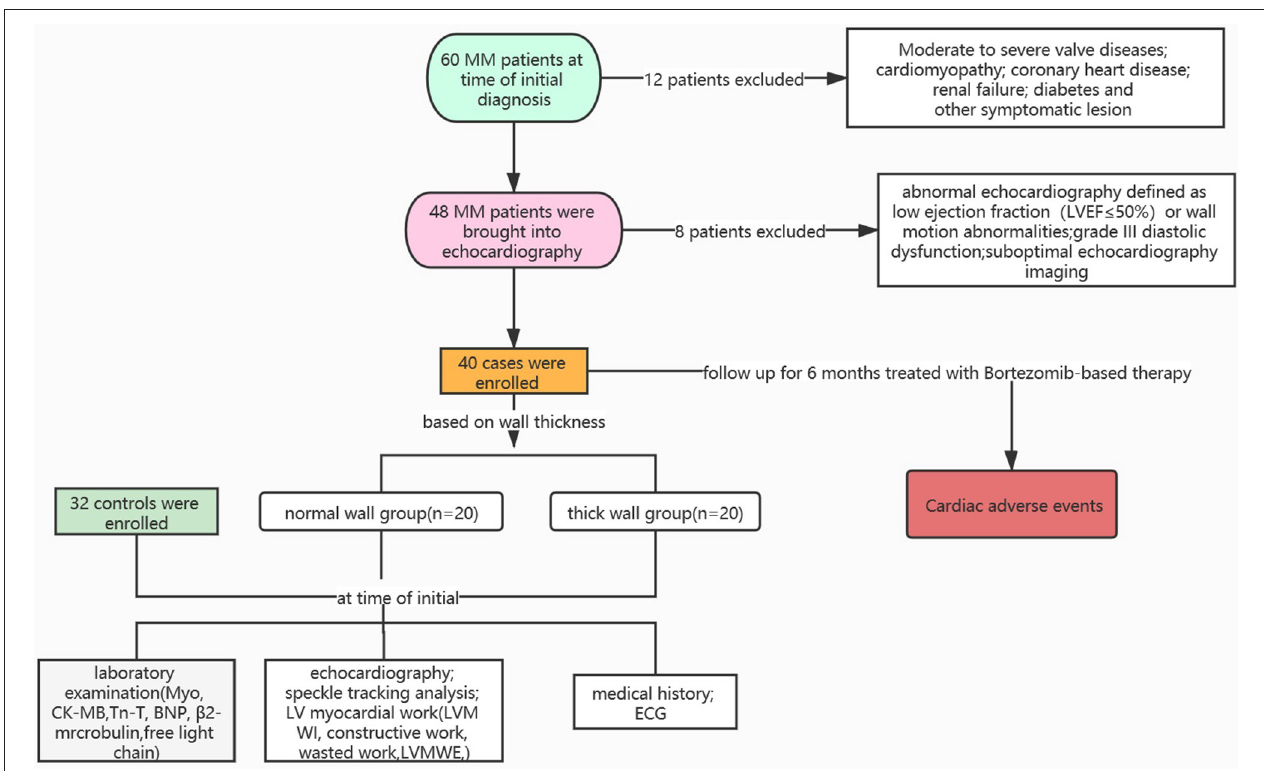
FIGURE 1 | Overview of patient selection process. Myo, myoglobin; CK-MB, creatine kinase-MB; TnT, troponin T; BNP, brain natriuretic